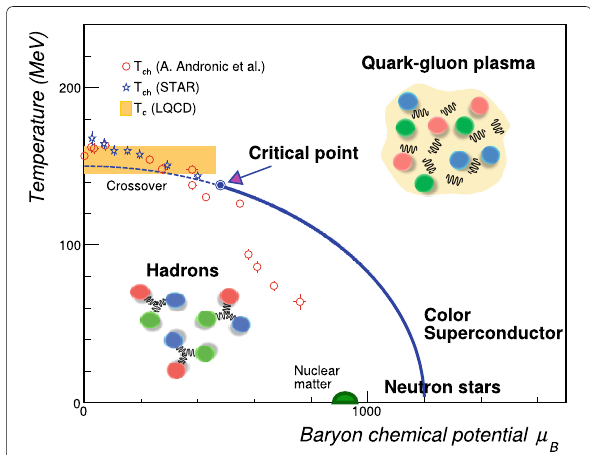
Fig. 1 A sketch of QCD phase diagram as functions of temperature and baryon chemical potential with conjectured phase boundaries indicated by solid and dashed lines and a possible critical point indicated by a solid circular point. Extracted T ch and μ B from a statistical mode [3, 4] are also plotted. See Section 5 for details